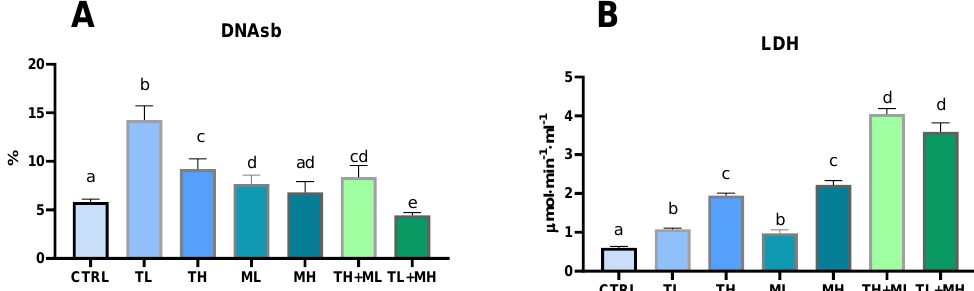
The level of DNA strand breaks was elevated in the liver of zebrafish exposed to terbuthylazine alone or to TH + ML mixture, as well as malathion at a low concentration (Figure 4A). The changes were more significant in the TL group than in the TH group. Exposure to the high concentration of malathion (50 μg L −1 ) had no effect on the DNA Figure 3. Effects of terbuthylazine (2 µ g L − 1 (TL) and 30 µ g L − 1 (TH)) and malathion (5 µ g L − 1 (ML) strand breaks level (Figure 4A). Only the TL + MH mixture led to a slight decrease in DNA fragmentation. and 50 µ g L 1 (MH)) exposures on immune ( A ) and endocrine ( B , C ) traits in zebrafish blood and Figure 3. Effects of terbuthylazine (2 µg L -1 (TL) and 30 µg L -1 (TH)) and malathion (5 µg L -1 (ML) LDH activity was upregulated in a dose-dependent manner by terbuthylazine and mitochondrial ( D , E ) and lysosome ( F ) related indices in hepatocytes. Columns with different letters and 50 µg L 1 (MH)) exposures on immune ( A ) and endocrine ( B , C ) traits in zebrafish blood and malathion. The mixtures induced a two-fold increase in response when compared to pes- mitochondrial ( D , E ) and lysosome ( F ) related indices in hepatocytes. Columns with different letters have significantly different values ( p < 0.05). The means and the standard errors of the mean are ticides effects alone (Figure 4B). have significantly different values ( p < 0.05). The means and the standard errors of the mean are presented. N = 6. presented. N = 6.